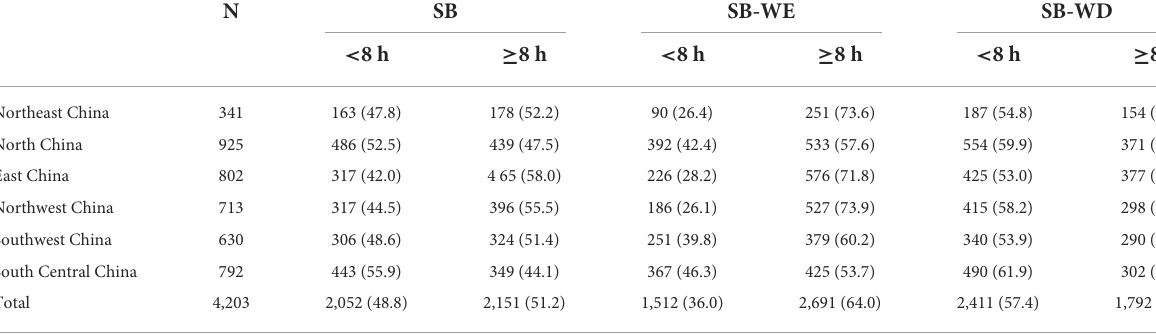
TABLE 9 Detection rate of high sedentary behavior in children and adolescents in different regions [N